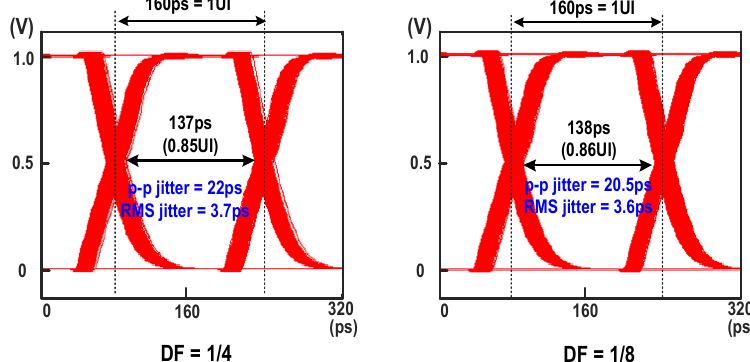
Figure 15. Post-layout simulation results of the recovered quarter-rate data with DF = 1/4 and 1/8. Table 1. CDR performance summary and comparison.